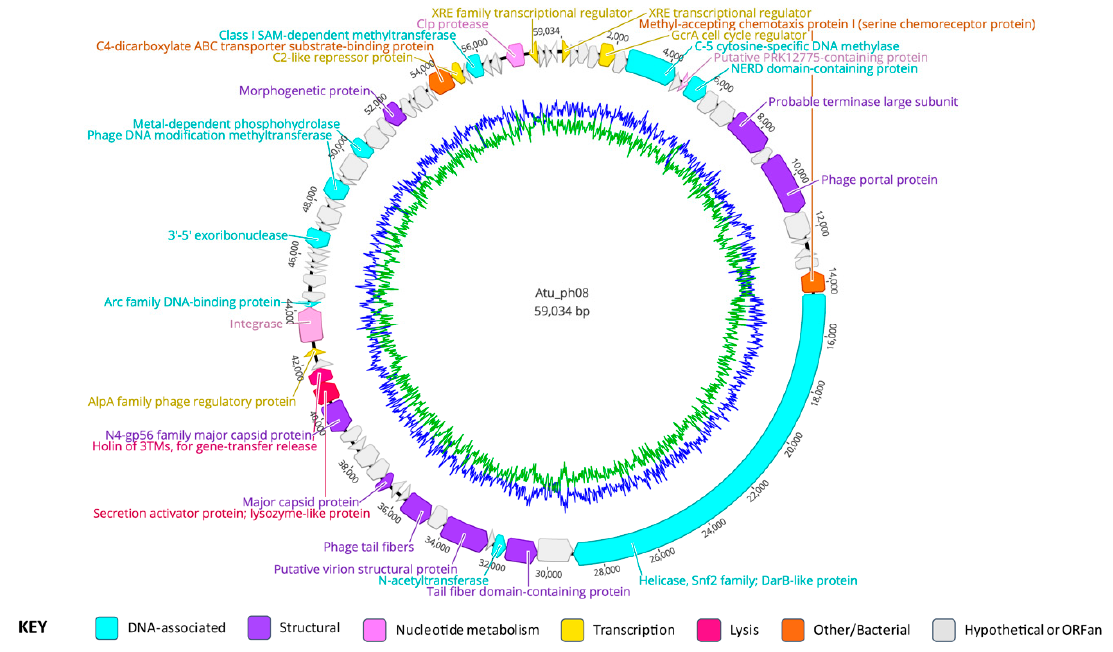
Figure 4. Genome annotation of Atu_ph08, color-coded by functional annotation. G + C content represented by inner circle: AT = green; GC = blue.